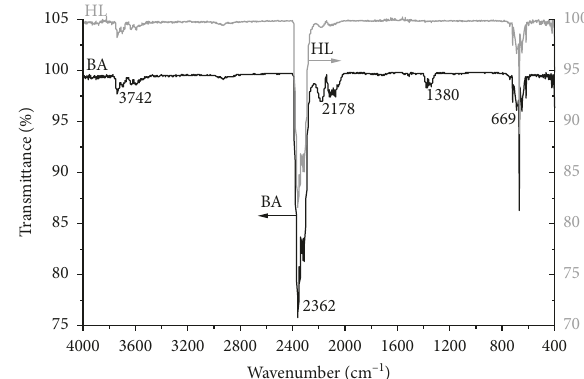
Figure 5: Infrared spectra of gaseous volatiles in the first com- bustion stage of BA and HL.